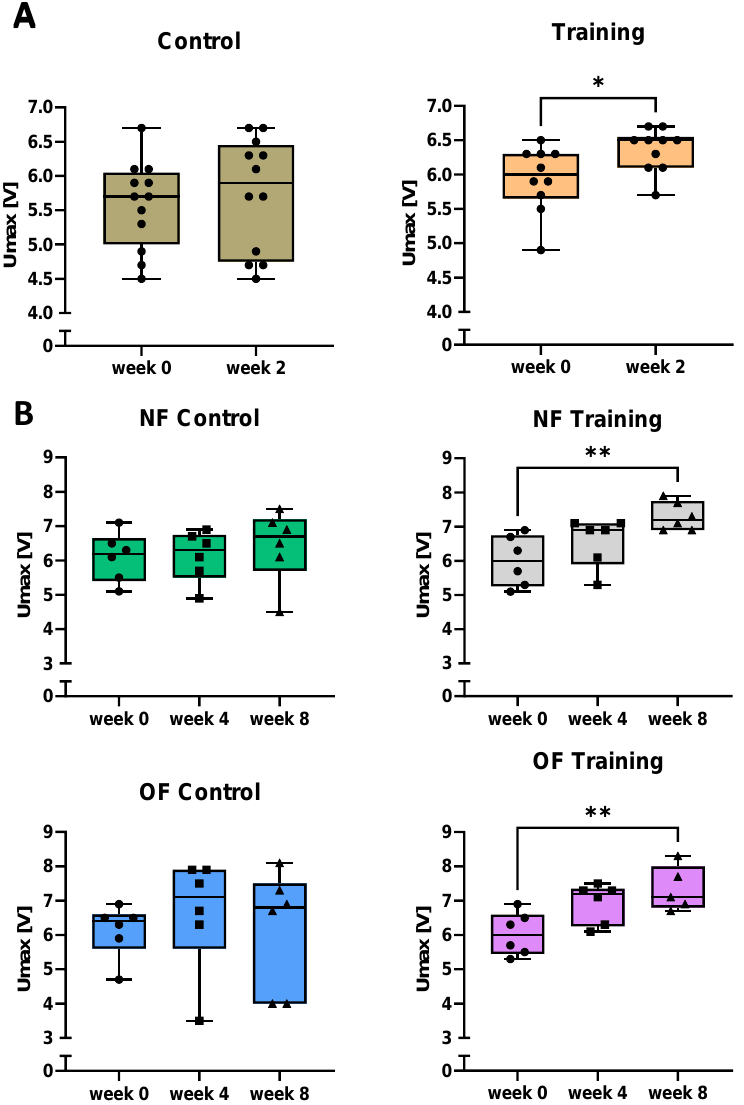
Figure 2. Swim tunnel training improved zebrafish swimming capability. ( A ): phase 1 training increased Umax significantly after 2 weeks of training ( p = 0.0323). Control: N = 12 fish, Training: N = 10 fish. Two-tailed unpaired t -test. ( B ): phase 2 training increased Umax in both NF and OF groups significantly after 8 weeks of training (NF-training p = 0.0037, OF-training p = 0.0012). N = 6 fish per group. One-way ANOVA test or Kruskal-Wallis test. NF: normal feeding; OF: overfeeding; Umax: maximum speed. * p < 0.05, ** p < 0.01.